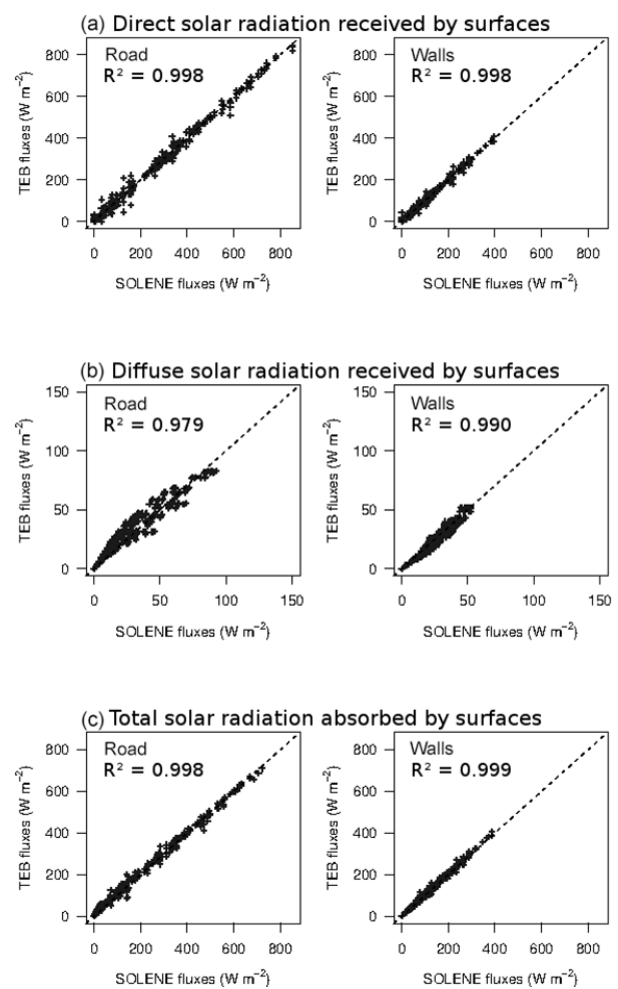
Figure 5. Scatterplots comparing TEB and SOLENE simulations of hourly direct (top) and diffuse (middle) solar radiation fluxes (Wm − 2 ) received by urban facets before multiple reflections, and total shortwave radiation fluxes (Wm − 2 ) absorbed by urban facets after inter-reflections (bottom) for urban canyons without vegeta- tion. Each scatterplot gathers the hourly fluxes simulated for the four seasons, the three aspect ratios, and the four street